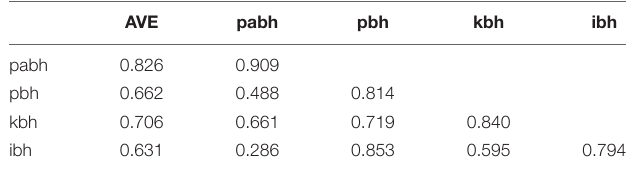
TABLE 4 | Discriminant